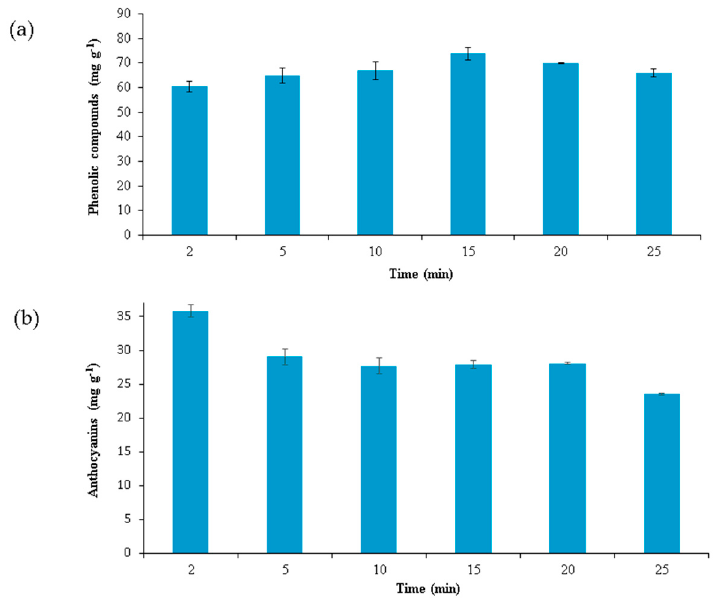
Figure 3. ( a ) Extraction kinetics of total phenolic compounds; ( b ) extraction kinetics of total anthocyanins.